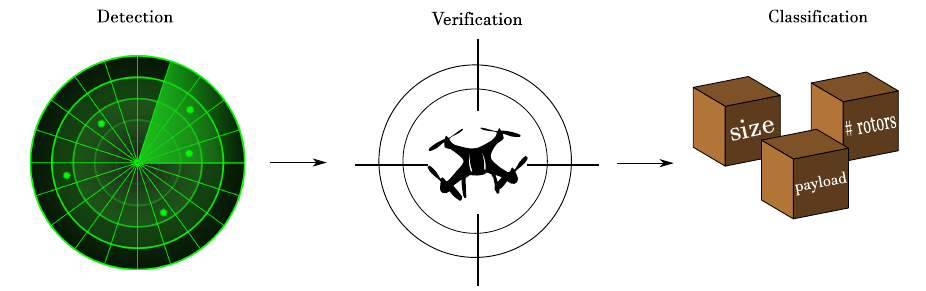
Figure 1. Target identification